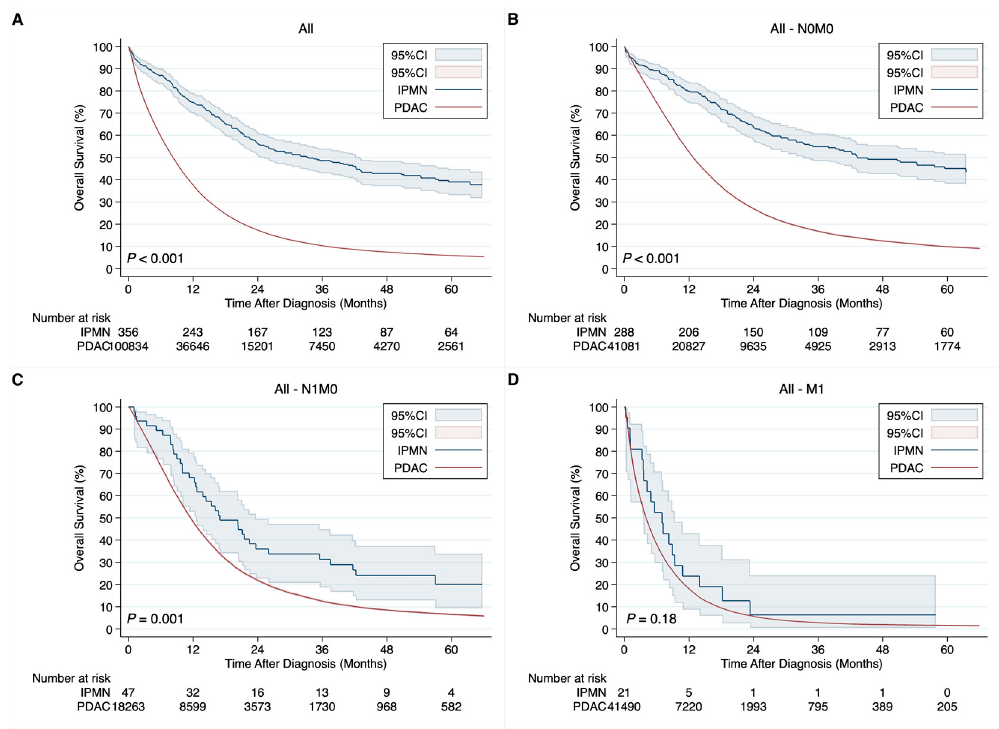
Figure 2. Kaplan–Meier curves demonstrating differences in overall survival in the entire cohort for invasive pancreatic ductal adenocarcinoma (PDAC) vs. invasive intraductal papillary mucinous neoplasm (IPMN) overall ( A ), in the subgroup of N0M0 disease ( B ), in the subgroup of N1M0 disease ( C ), and in the subgroup of M1 disease ( D ).